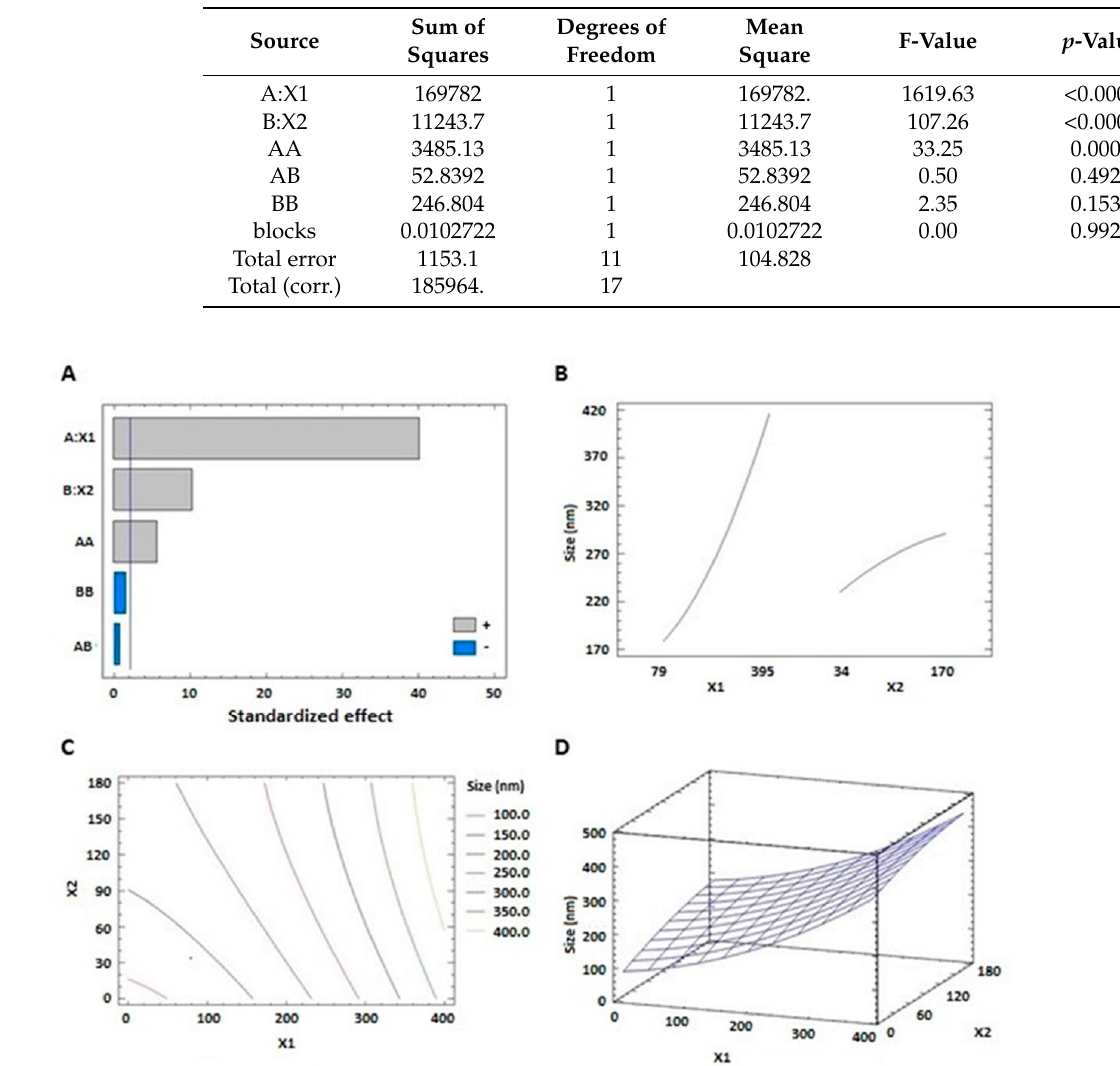
Figure 1. Standardized pareto chart ( A ), main effects plot ( B ), contour 2D plot ( C ), and response 3D plot ( D ) showing the effects and interaction between PL and SV amounts on the vesicle size of THQ–PL–SV phytosomes. Abbreviations: THQ, thymoquinone; PL, Phospholipon ® 90H; SV, scorpion venom peptide.